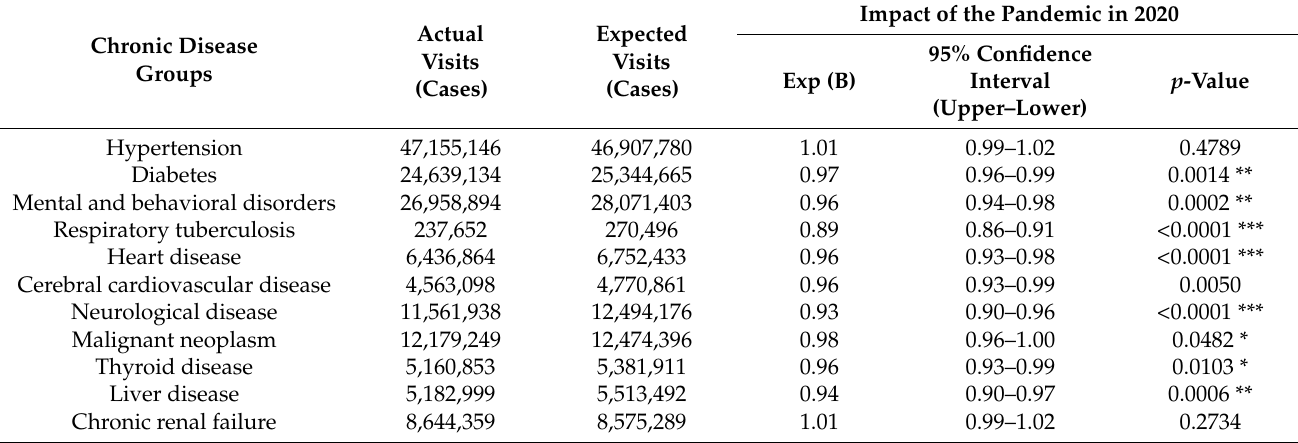
Table 3. Assessment of the Pandemic’s Impact on OP visits in 2020 (11 chronic disease